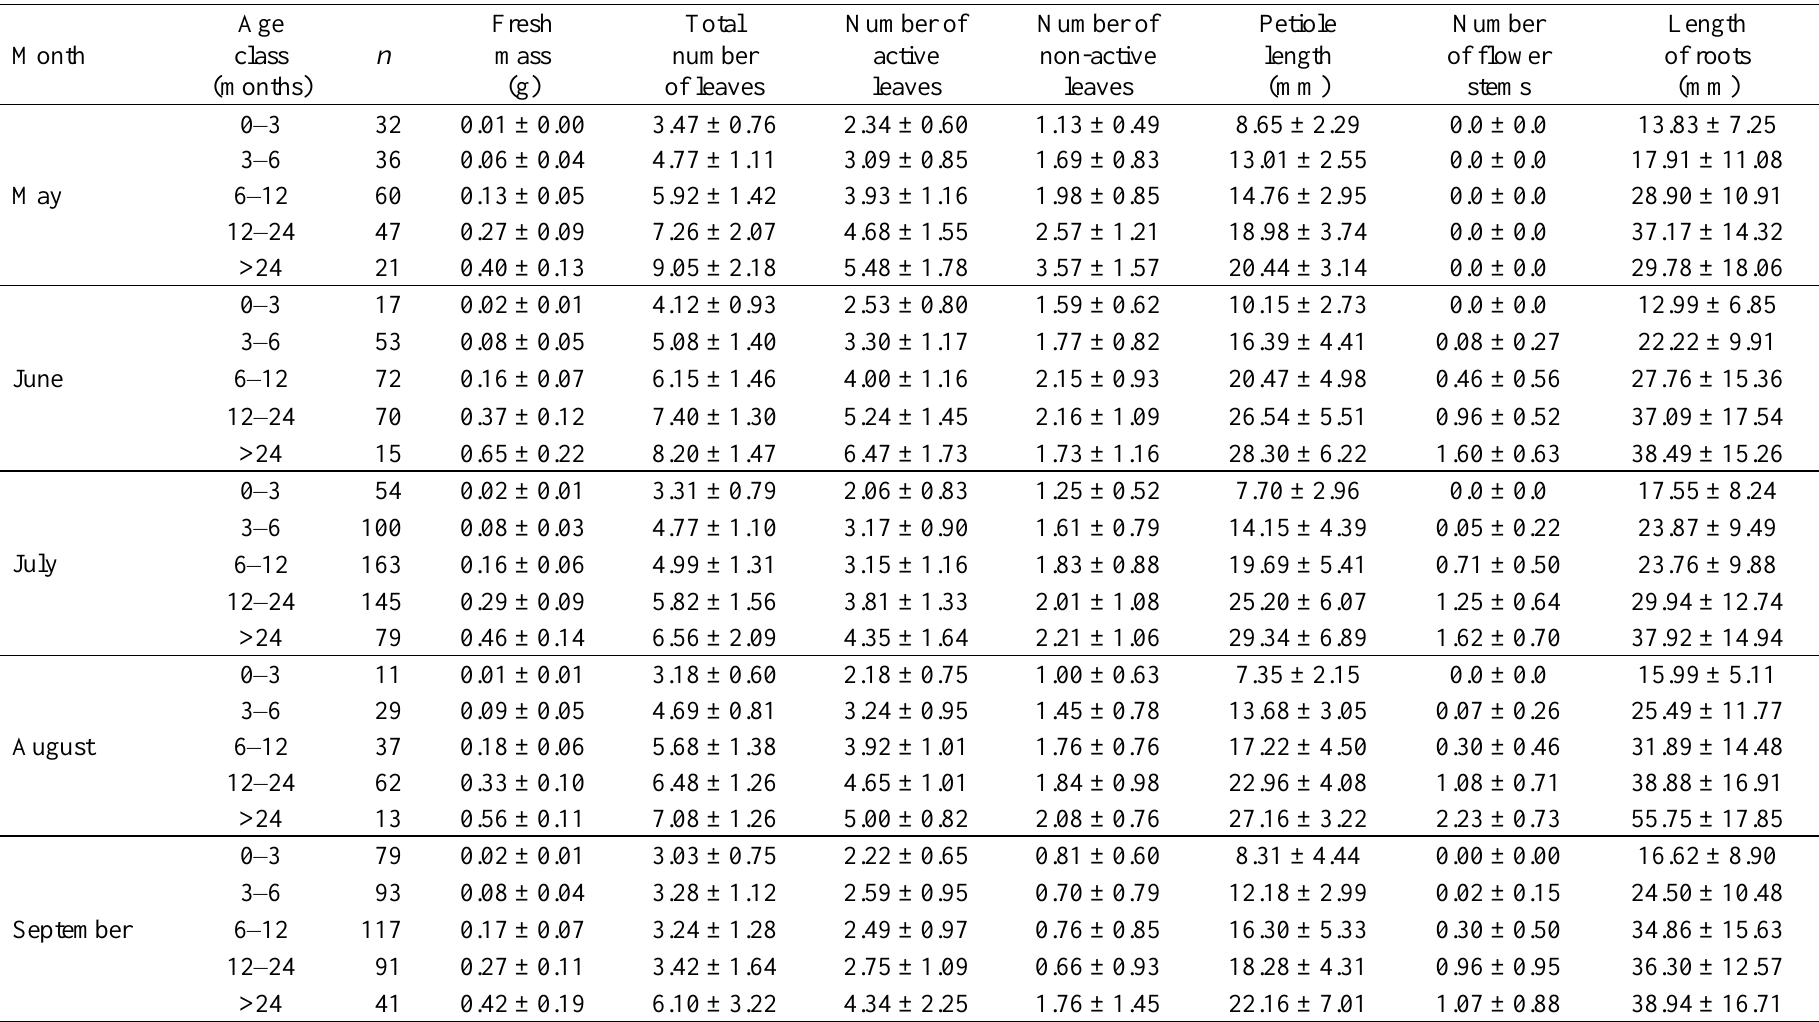
Table A2. Morphological features of Drosera rotundifolia growing in 2013 and 2014 on the Sphagnum papillosum field; mean values ± SD . n = number of individual